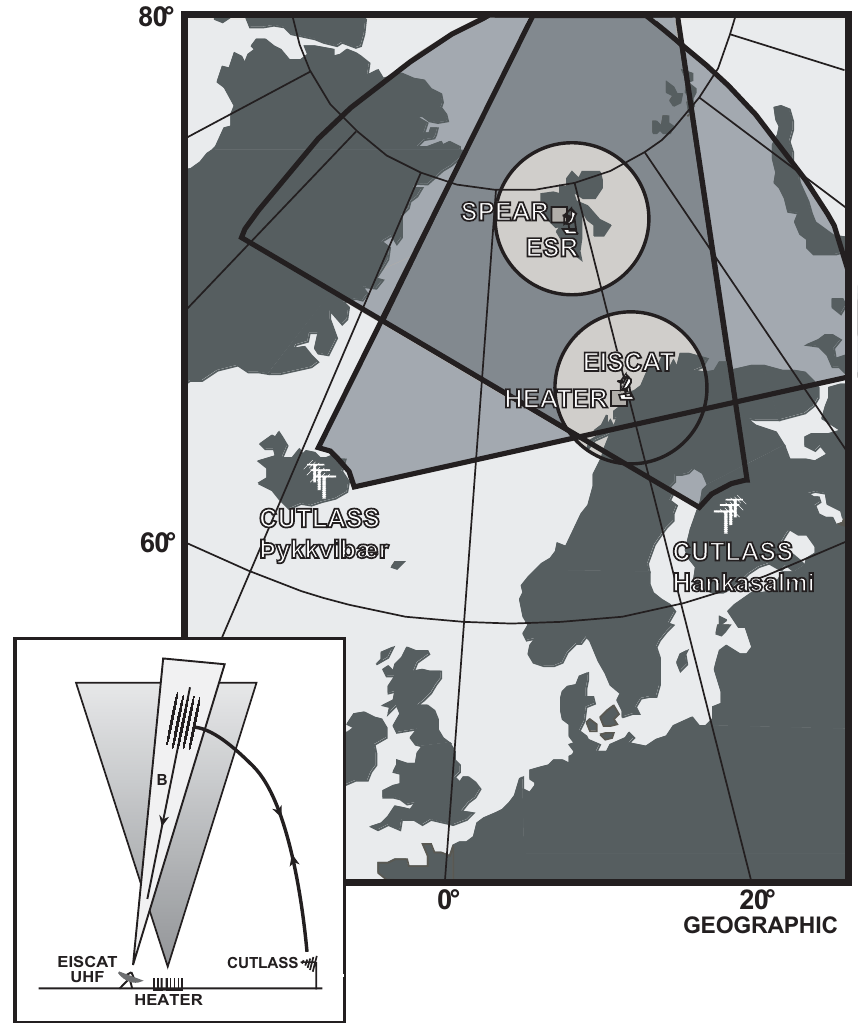
Fig. 2. A map illustrating the locations of the various instruments relevant to this study. Inset: a schematic representation of field-aligned irregularity generation by a high power heater and a half-hop radio path of an HF radar which receives backscatter from these